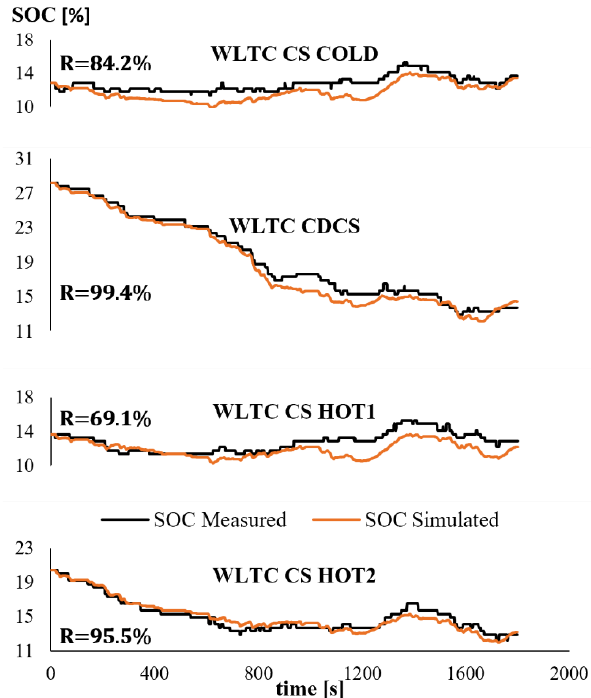
Figure 4. SOC measurement vs. simulation — examples .